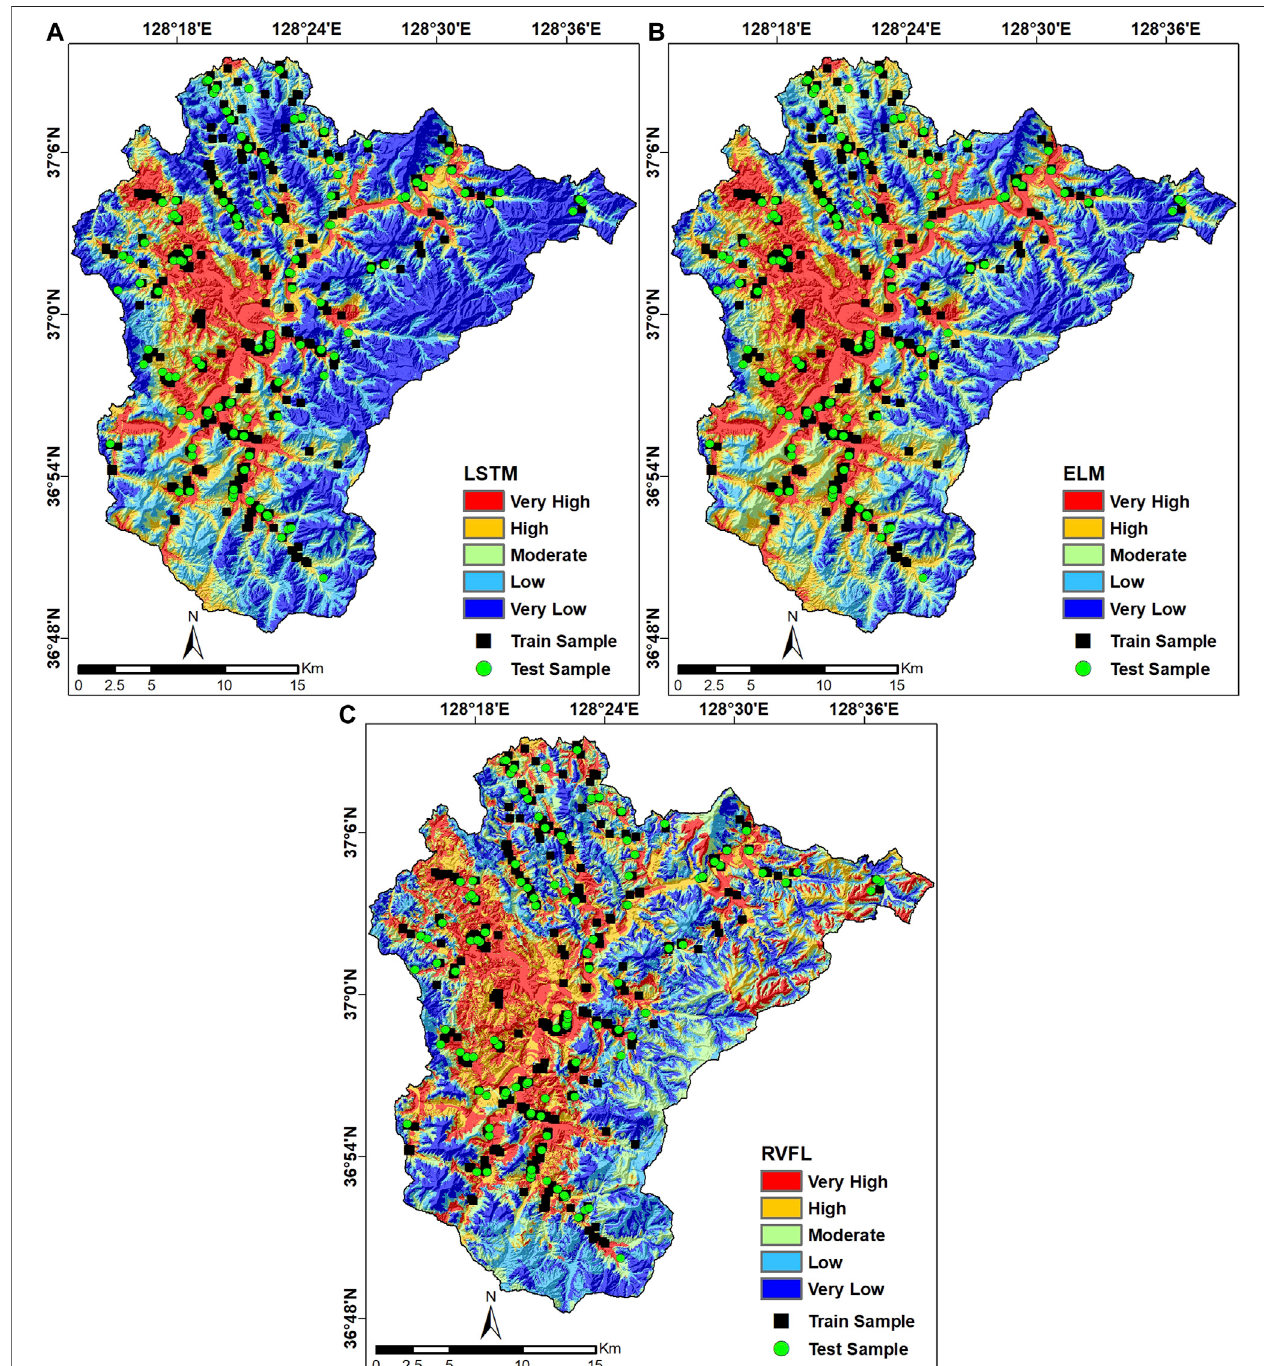
FIGURE 5 | Radon potential maps derived from the (A) LSTM, (B) ELM, and (C) RVFL models.